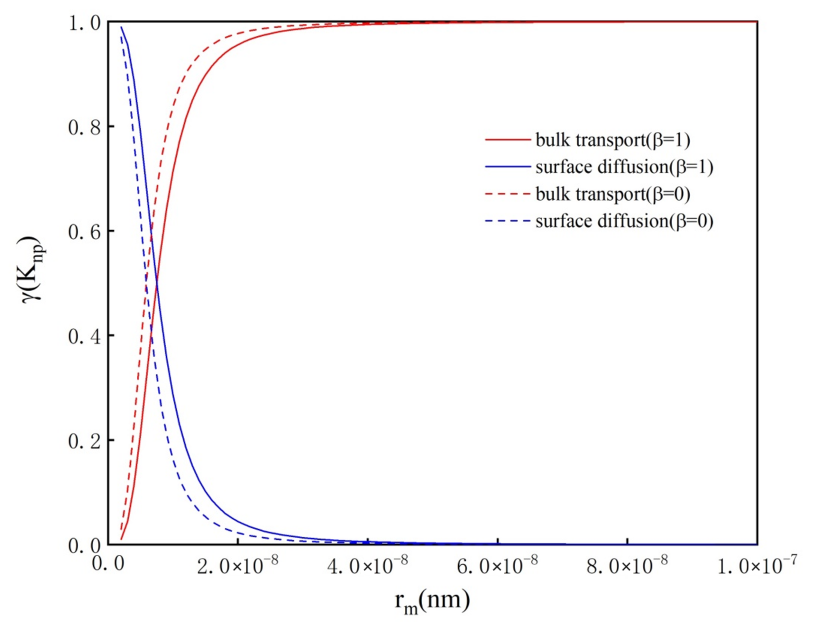
, the ratio of flow p